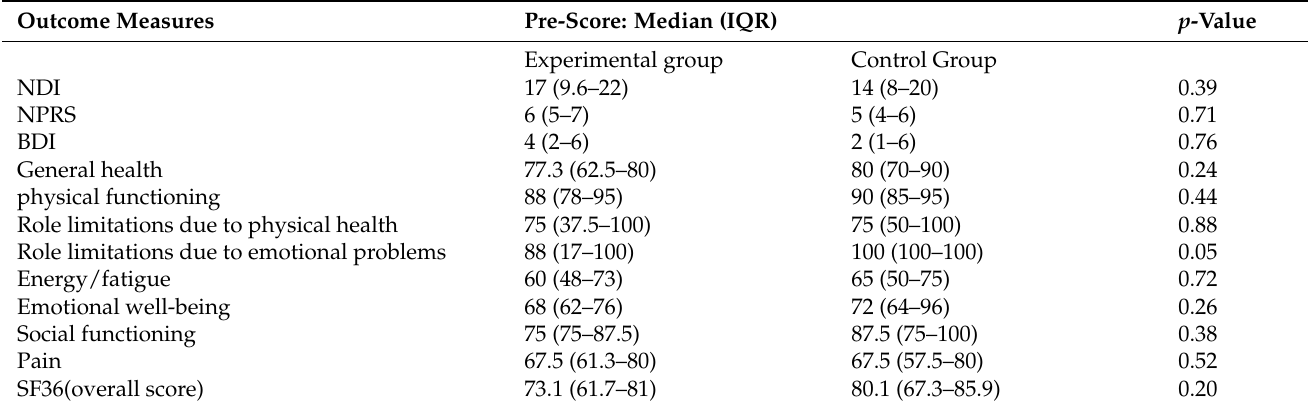
Table 3. Between-groups comparison of baseline outcome measures.